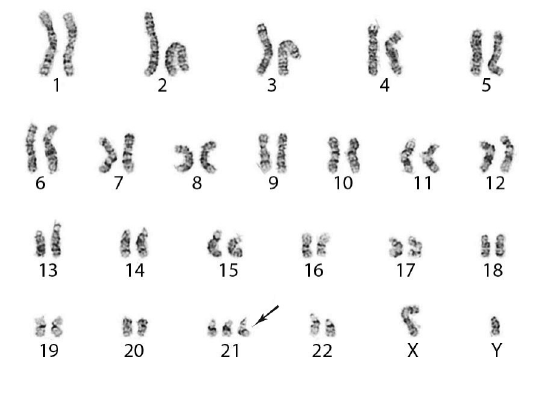
Figure 3. Trisomy 21 as the sole acquired karyotypic abnormality in our patient with acute myeloid leukemia (arrow).